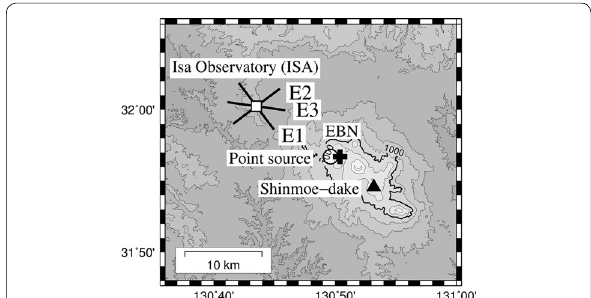
Fig. 1 Map showing the location of Shinmoe-dake volcano crater and observation sites. The solid triangle indicates the Shinmoe-dake volcano crater and the open square indicates the ISA observation site, where the strain data were recorded. Thick bars at ISA show the azimuths of the extensometers, and contours give the surface topography in 200-m intervals. The open circle represents the location of the point inflation source that corresponds to the shallow magma chamber inferred from GNSS data (Nakao et al. 2013). The cross represents the location of AMeDAS station Ebino (EBN) of the Japan Meteorological Agency, where the precipitation data used in this study were